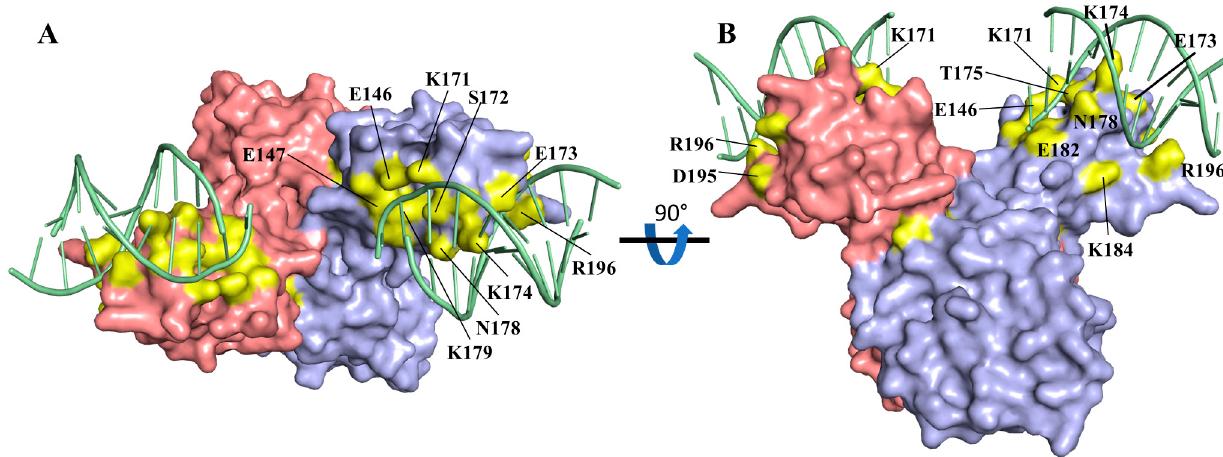
Figure 6. Conserved residues in Csa3a wHTH domain. ( A ) Surface model of Csa3a with strictly conserved residue in the wHTH domain in yellow and DNA in orange. ( B ) Rotated 90° about the horizontal axis. The majority of the conserved surface residues in the wHTH domain are located at the putative protein-DNA interface.